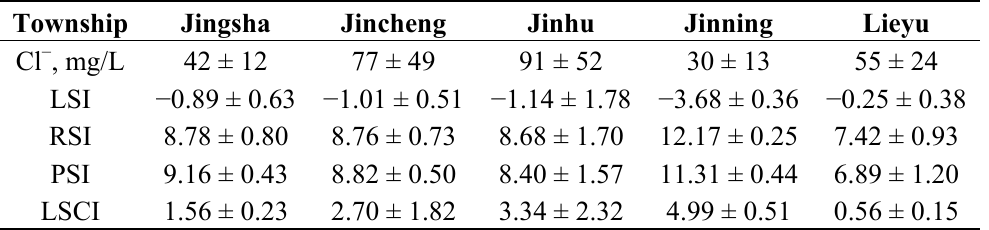
Table 6. Assessment of scaling and corrosion tendency-underground-water quality in Kinmen County